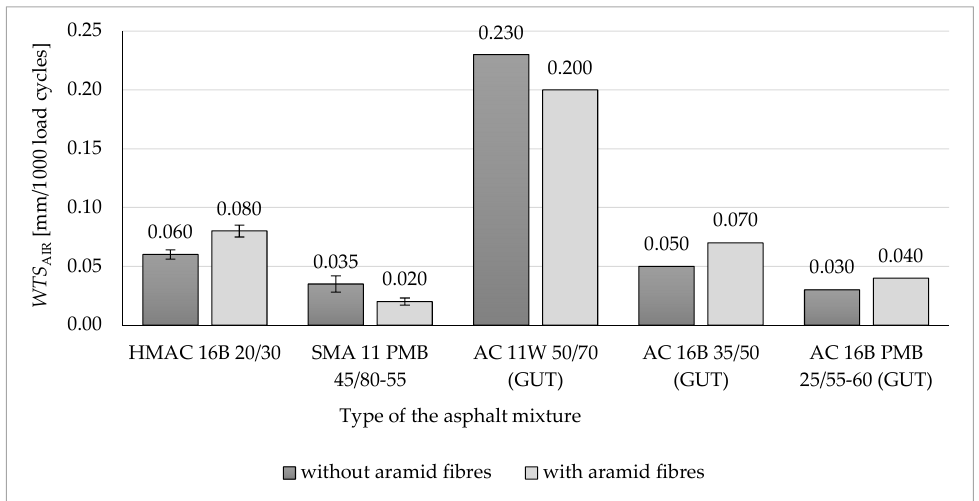
Figure 5. Wheel tracking slope— WTS AIR of the analysed HMA (including HMA examined at the Gdańsk University of Technology [26]).